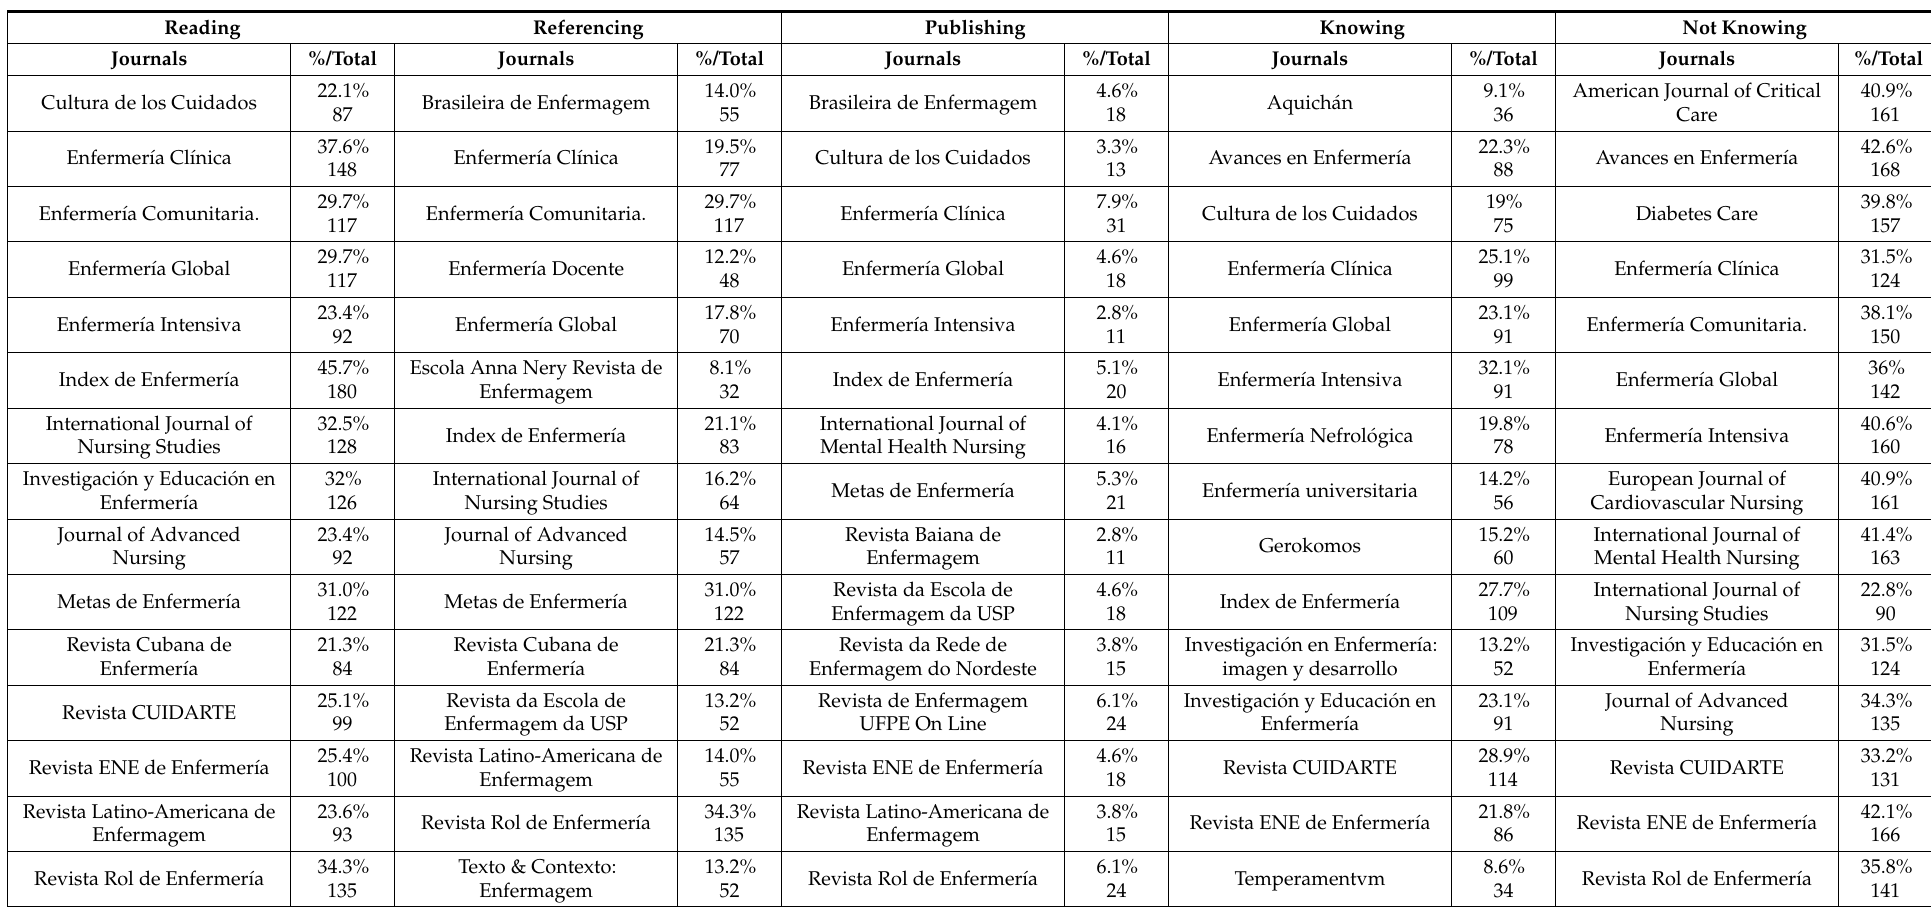
Table 4. 1Q_LcEE-CAPC Questionnaire. Responses to “reading, referencing, publishing in, and knowing or not knowing journals in Spanish, Portuguese, and